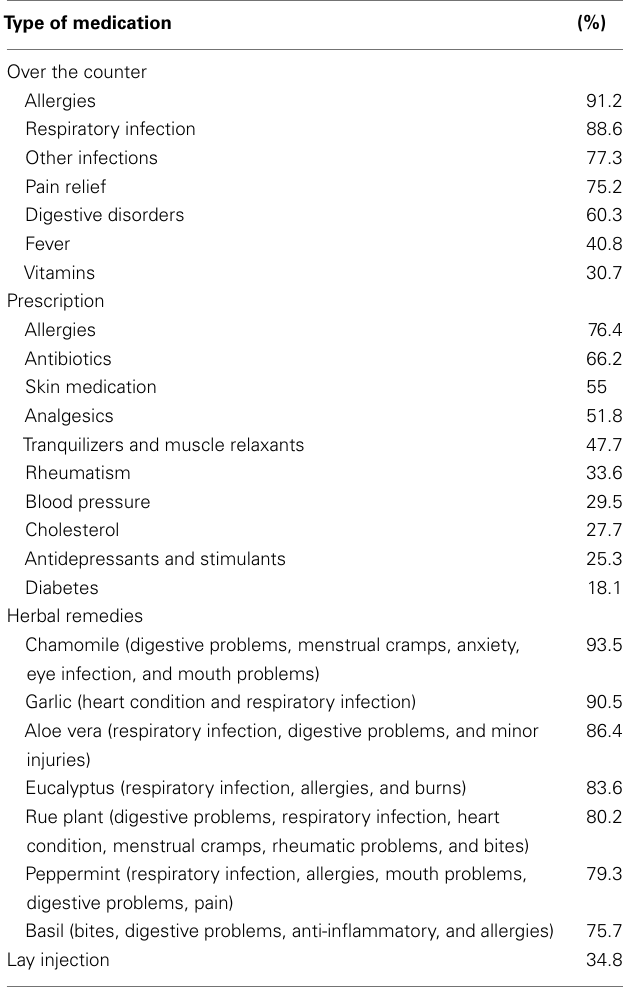
Table 3 | Self-reported health symptoms experienced right after work in the last 30days .